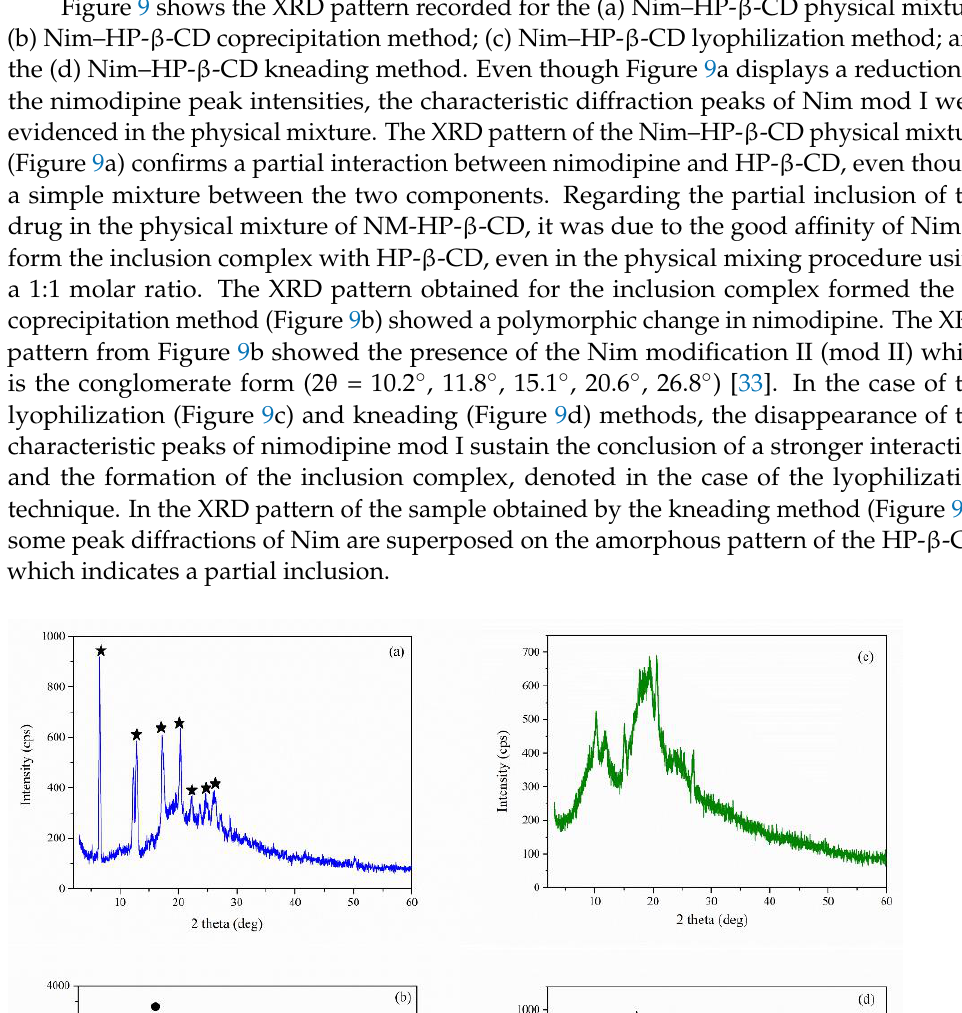
Figure 10. XRD pattern of ( a ) Nim – Me- β -CD physical mixture; ( b ) Nim – Me- β -CD coprecipitation method; ( c ) Nim – Me- β -CD lyophilization method; ( d ) Nim – Me- β -CD kneading method ( — Nim mod I; — Nim mod II). Similar to the case of the Nim – HP- β -CD inclusion complexes, the XRD diffracto- grams of Nim – Me- β -CD were obtained using different synthesis methods from Figure